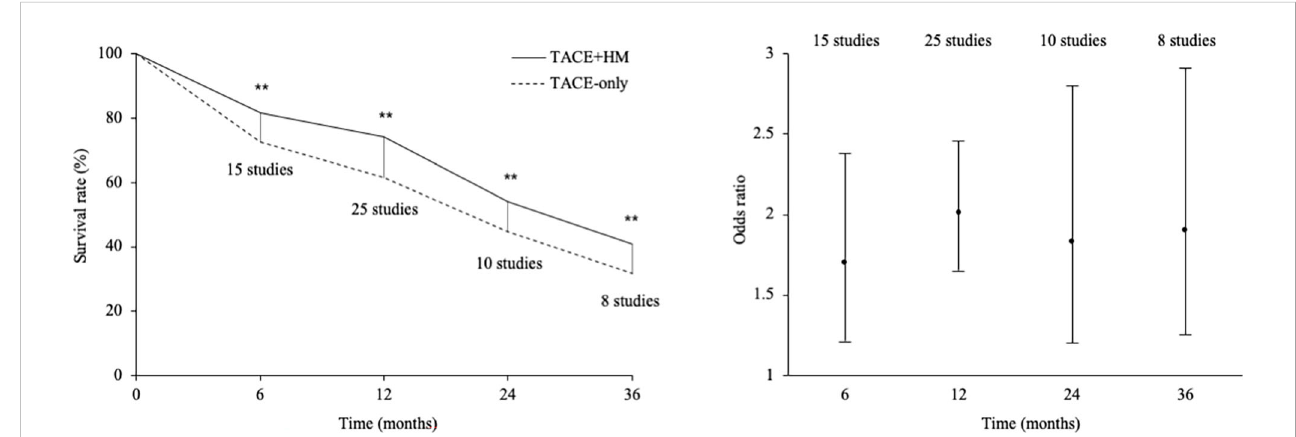
FIGURE 2 Survival rate and odds ratio at 6, 12, 24, and 36 months. ** indicated that P <